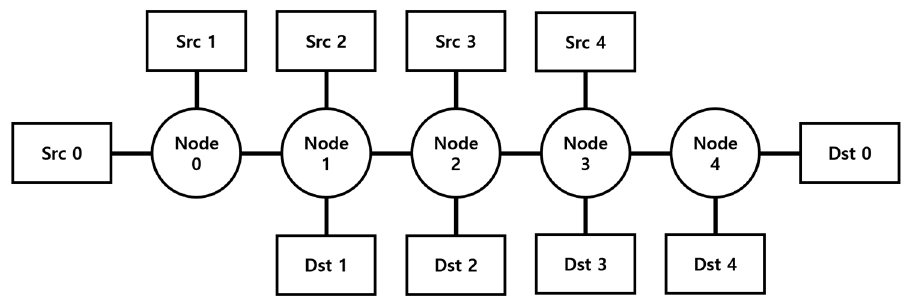
Table 6. Packet generation scenario in topology 1.